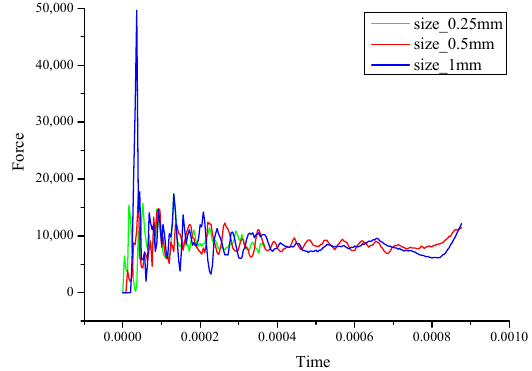
Figure 5. Comparison the results of different mesh sizes.